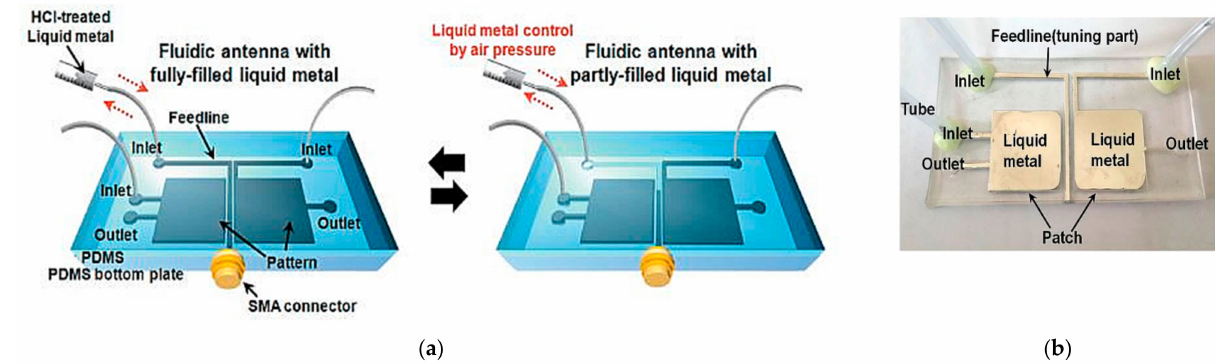
Figure 8. The proposed frequency tunable antenna. ( a ) Schematic antenna. ( b ) Fabricated antenna [32].